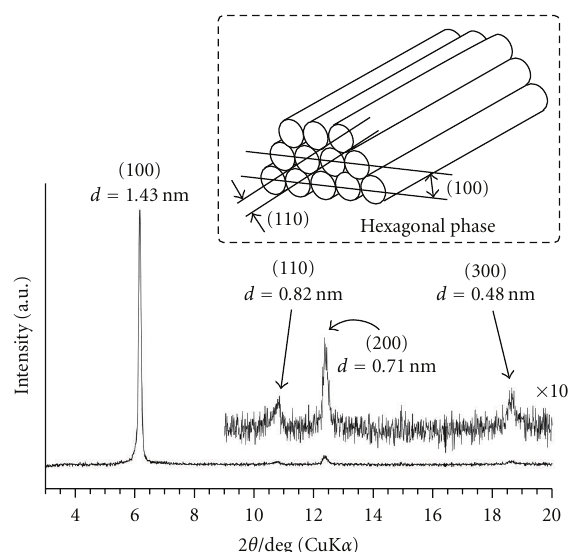
Figure 1: XRD pattern of PSQ-NH 3+ Cl − . Relative humidity (RH) during XRD measurements was